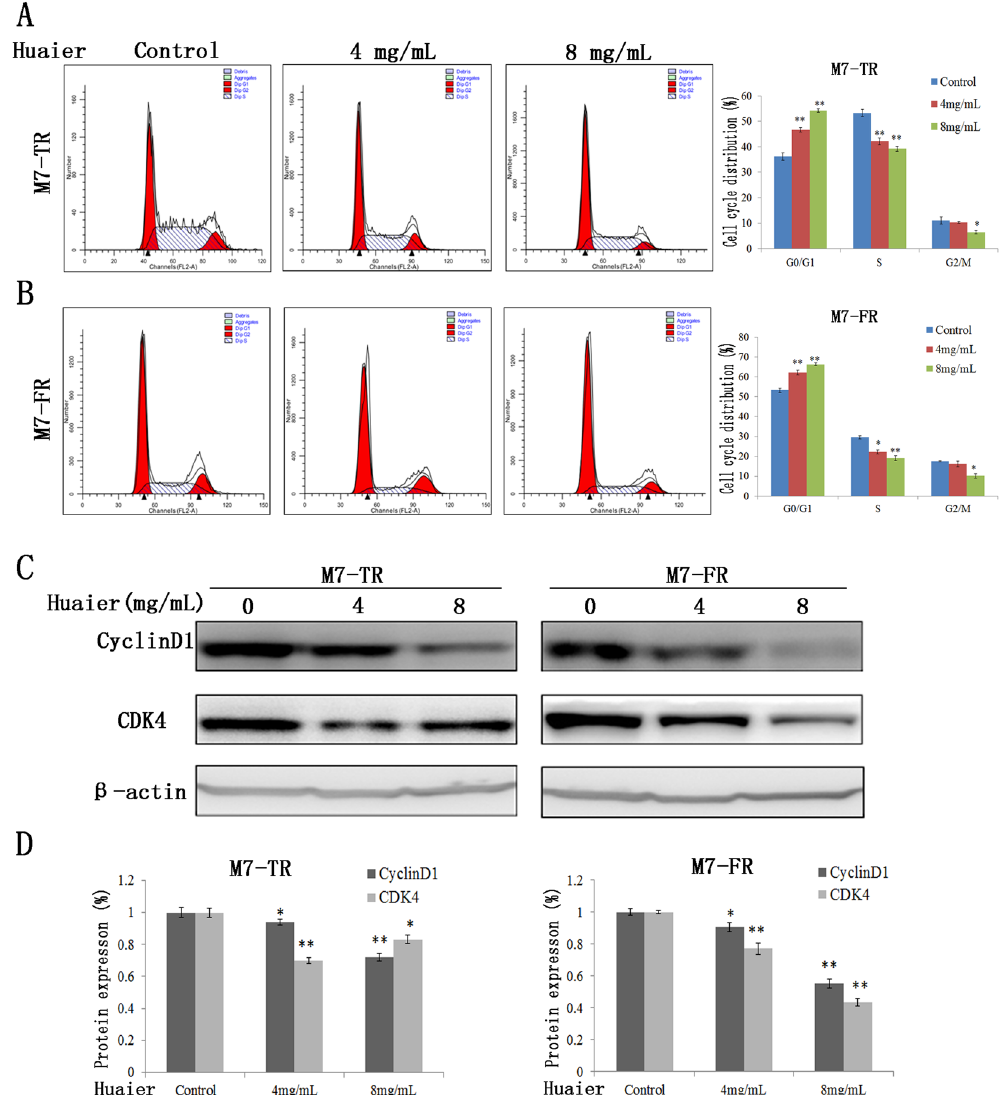
Figure 2. Induction of G0/G1 phase arrest in M7-TR and M7-FR cell lines by Huaier extract. The DNA content of M7-TR ( A ) and M7-FR ( B ) cells, treated as above for 48 h, was detected and analysed by flow cytometry. The data represent the results of three independent experiments; * P < 0.05 or ** P < 0.01. Changes in cell cycle progression could be due to cyclin D1 and CDK4 in the M7-TR ( E ) and M7-FR ( F ) cells. The data are presented as the mean ± SD of three separate